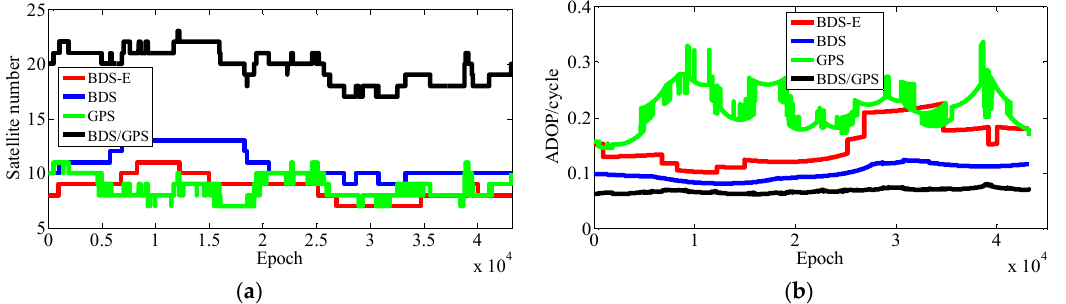
Figure 12. Satellite number and ADOP of four systems for group B. ( a ) The satellite number of four systems for group B. ( b ) The ADOP of four systems for group B.